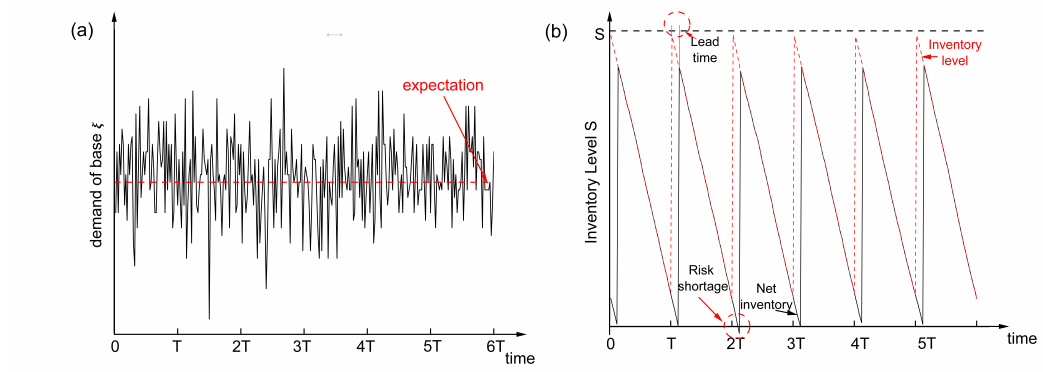
Figure 2. The time-variant characteristic sketch maps: ( a ) the distribution of demand from base ξ and ( b ) inventory level S